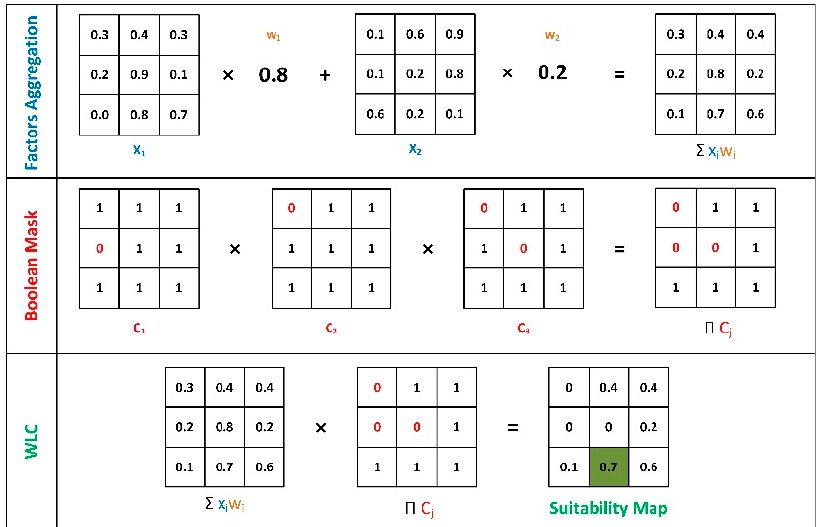
Figure 2. An example of how the methodology is working, by considering the Boolean Mask ( top ), Factors Aggregation ( middle ) and Weighted Linear Combination (WLC) ( bottom ), where c 1 , c 2 and c 3 are constraints, x 1 , x 2 are suitability factors and w 1 and w 2 are factor weights. Winchester District as a whole has over 9000 road segments, ranging from motorways (highways) to restricted secondary-access roads, with 25% of these segments situated within Winchester City. The constraint/restriction criteria are listed and detailed in Table 2. The constraints are numbered in the order in which they were applied to the AHP- GIS model. Table 2. Table of constraint/restriction